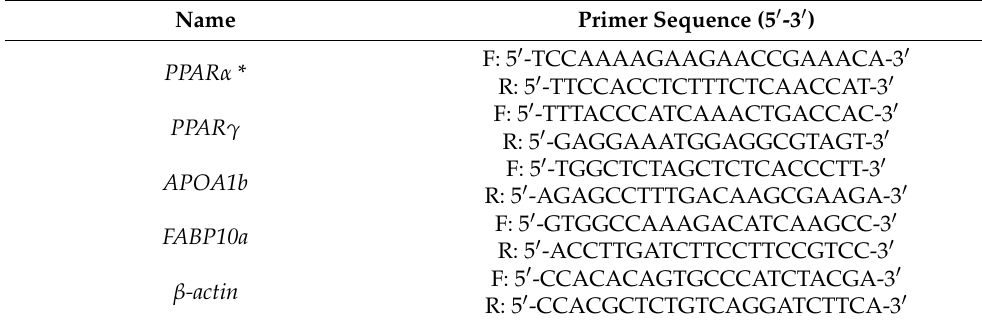
Table 2. Sequences of primers used for